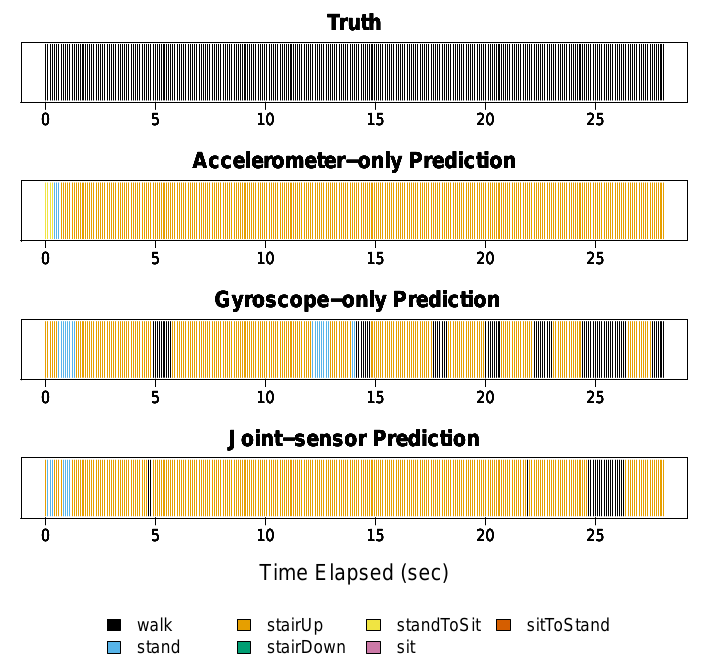
Figure 5. Step 3 for participant 3: slow walking. This figure presents the results of participant 3 during step 3 for slow